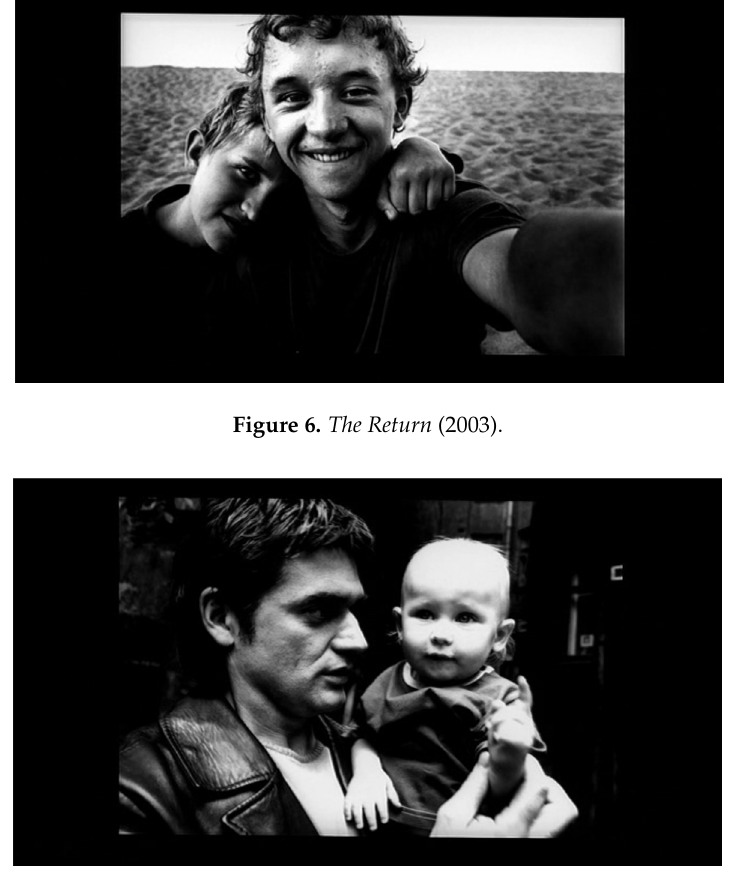
Figure 7. The Return (2003).